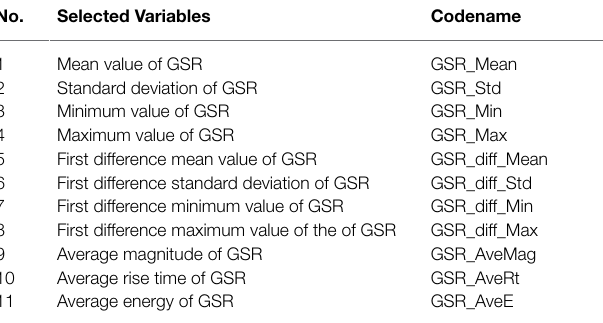
TABLE 4 | Selected variables.